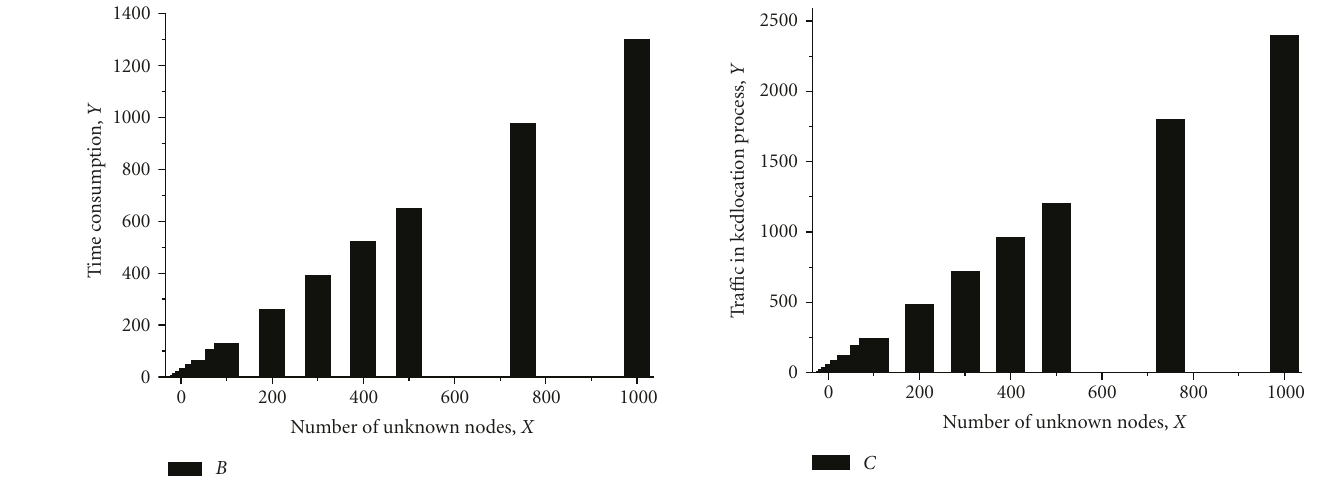
Figure 6: Time consumption in Kcdlocation process. Figure 7: Tra